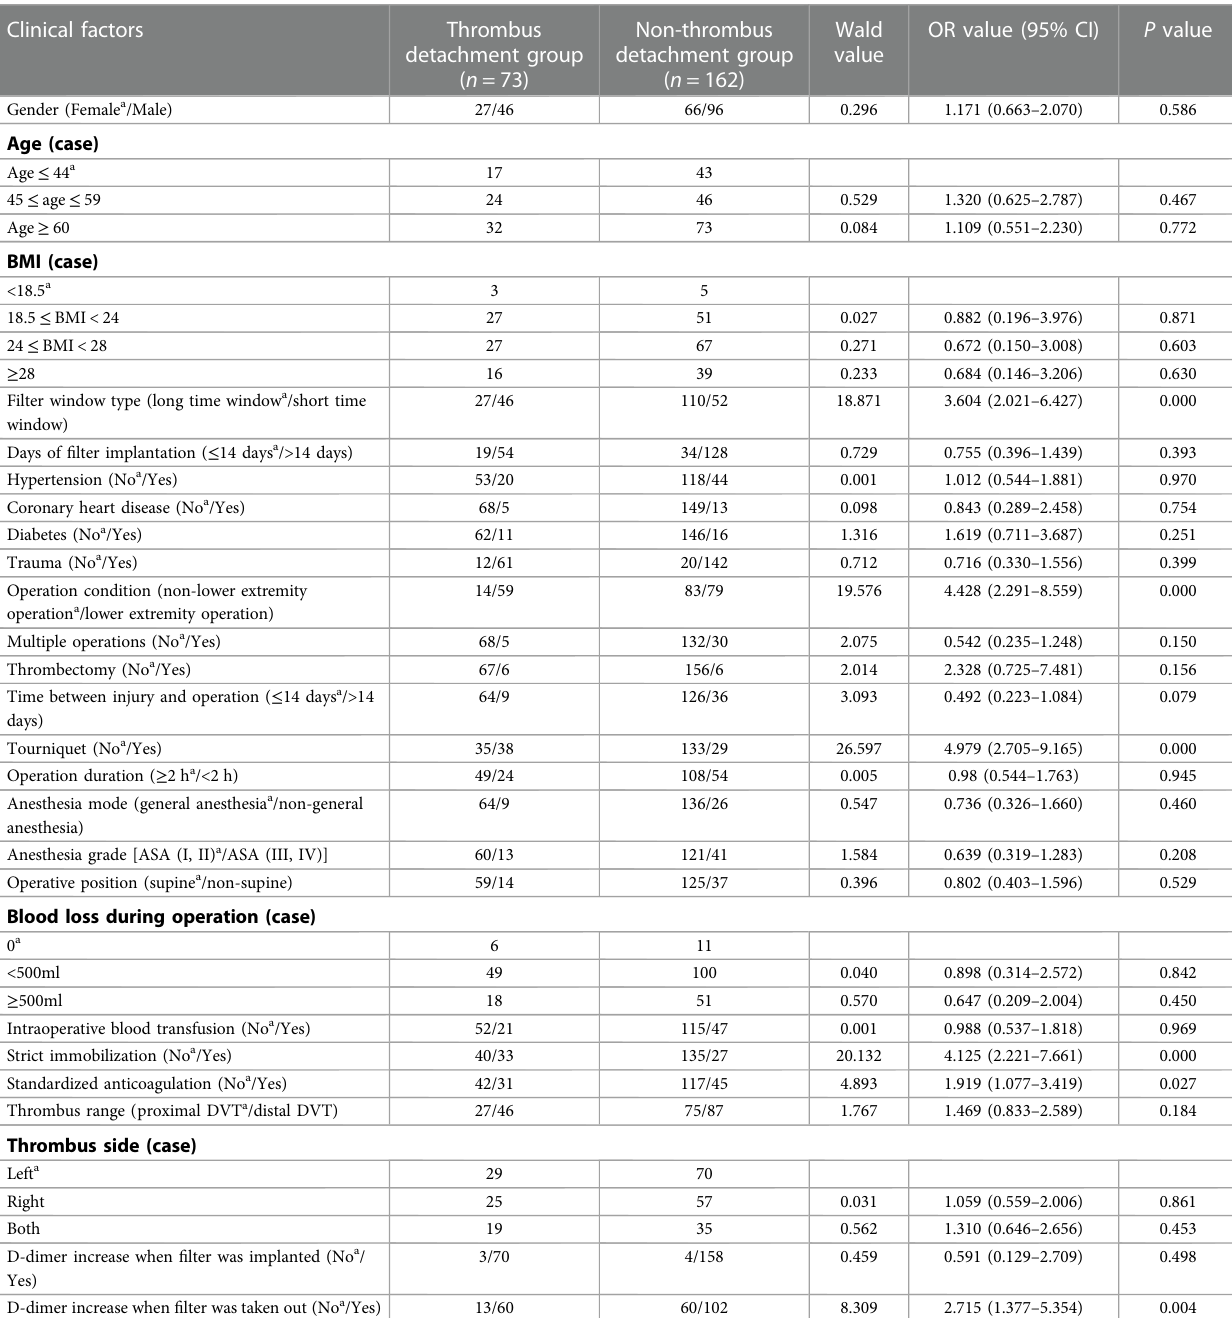
TABLE 2 Univariate analysis of risk factors of lower extremity DVT detachment in orthopedic patients in training set. Clinical